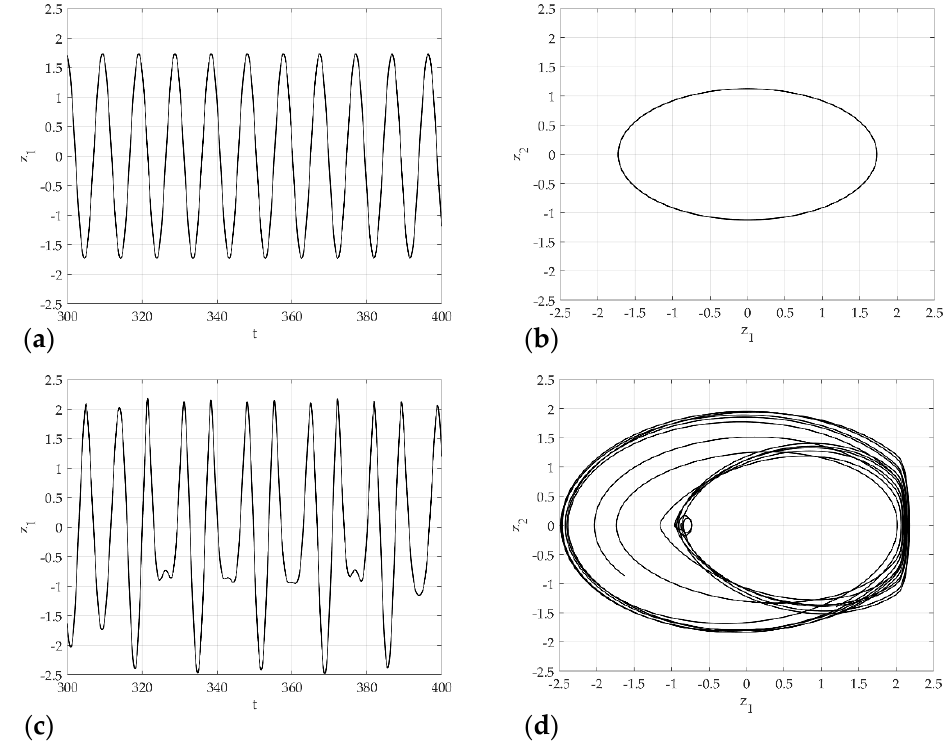
Figure 9. Trajectory, ( a ) time signal without impact, ( b ) phase portrait corresponding to ( a ), ( c ) time signal with impact, ( d ) phase portrait corresponding to ( c ).